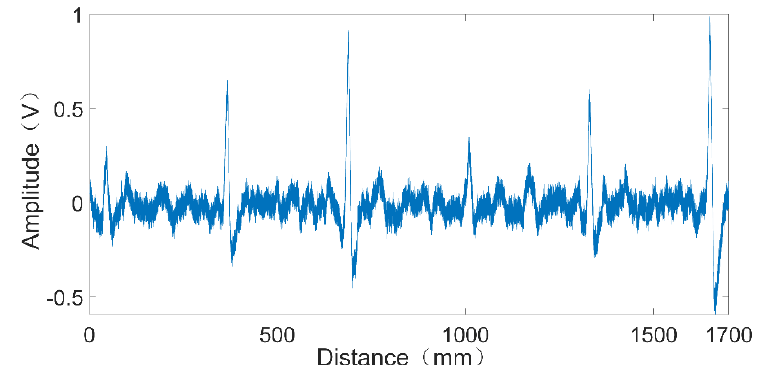
Figure 9. Signals received by the MFL sensor.